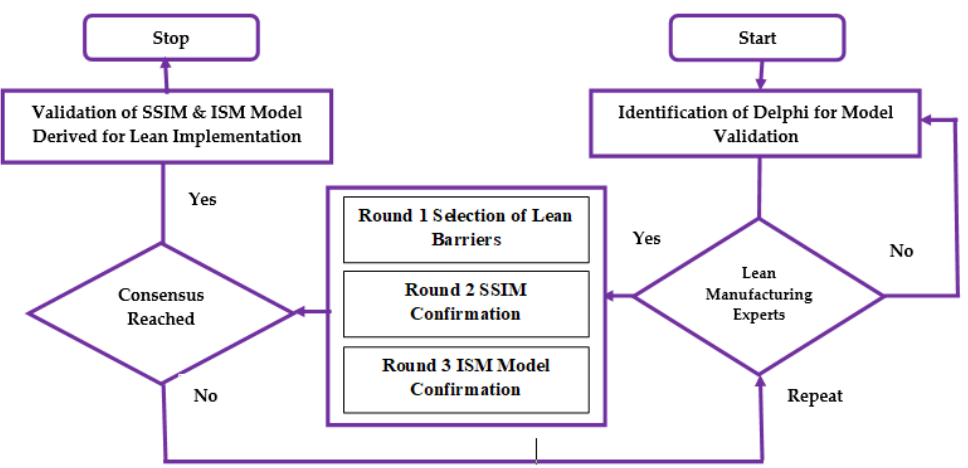
Figure 4. Validation of ISM model through Delphi technique.